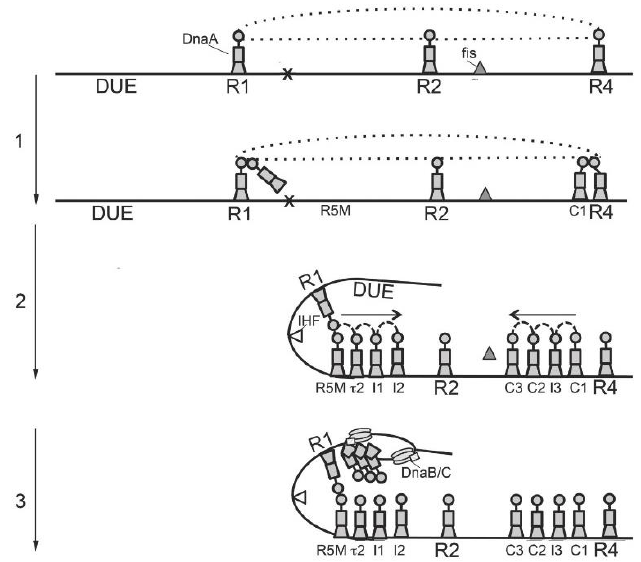
Figure 2. Model of orisome assembly in E. coli . Stage 1: DnaA is bound to the high affinity site R1, R2 and R4. The Escherichia coli gene encoding the FIS Protein (Fis) is also bound. Interactions between the bound DnaA molecules (shown by the dotted line) constrain the origin and this prevents the integration host factor (IHF) from binding to its recognition site (shown by X). Low a ffi nity sites are unoccupied. DnaA bound to R4 and R1 recruits DnaA for binding to their proximal site, but the lack of IHF-induced bending prevents donation from R1. Stage 2: Progressive cooperative binding of DnaA in the right region of the chromosomal replication origin ( oriC ) (indicated by the dashed arches) results in the occupation of the low a ffi nity I3, C2 and C3 sites, and a displacement of Fis. This allows IHF to bind, and the induced DNA bend allows an interaction between R1 and R5M, followed by a progressive DnaA binding to the oriC ’s left region. Arrows indicate the direction of progressive binding. Stage 3: Full occupation of double-stranded DNA recognition sites in oriC by DnaA results in strand separation in the DNA Unwinding Element (DUE). A DnaA filament binds the single-stranded DNA and recruits DnaB (helicase) and DnaC (helicase loader). See the text for details.